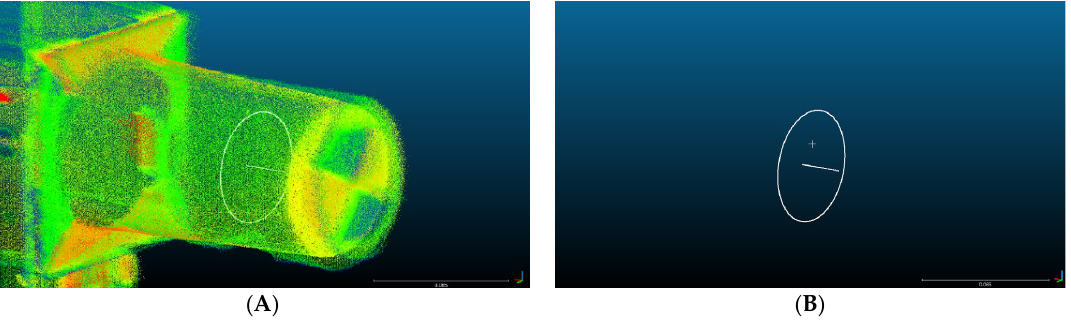
Figure 11. Velodyne ® HDL–32E with individual scanner and receiver pairs (32 total) plotted along central axis with focal point locations plotted for every 0.01° of rotation ( A ) with and ( B ) without the scanner point cloud.